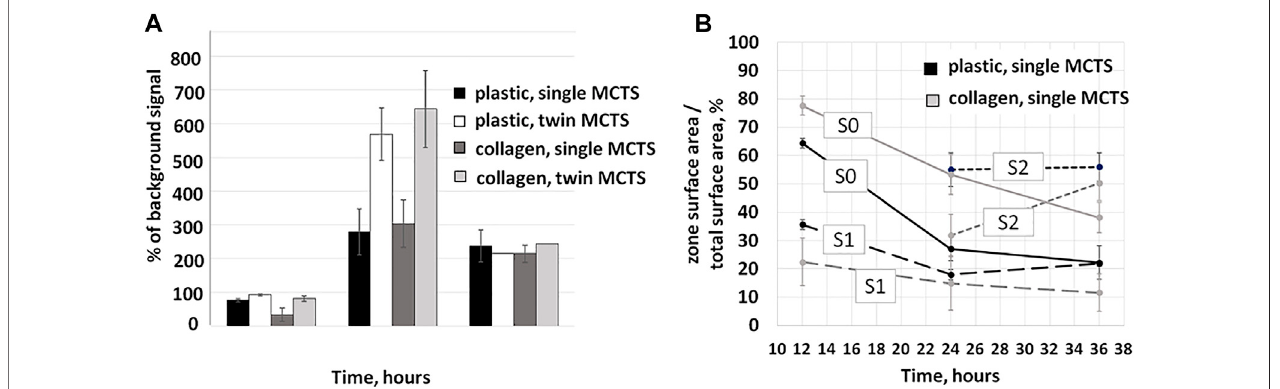
FIGURE 4 | Changes in metabolic activity and area share of single and twin MCTS in the fi rst 36 h of culturing. (A) Resazurin assay was used to assess metabolic activity of the cells. Increase of the fl uorescence ratio relative to background values demonstrates an increase in metabolic activity. Data obtained from two experiments with three to nine technical repeats (B) Time-dependent changes in migration zone area shares of the total area of the MCTS. Data obtained from three repeats and presented as the mean ± SD. dynamically change over the time course.